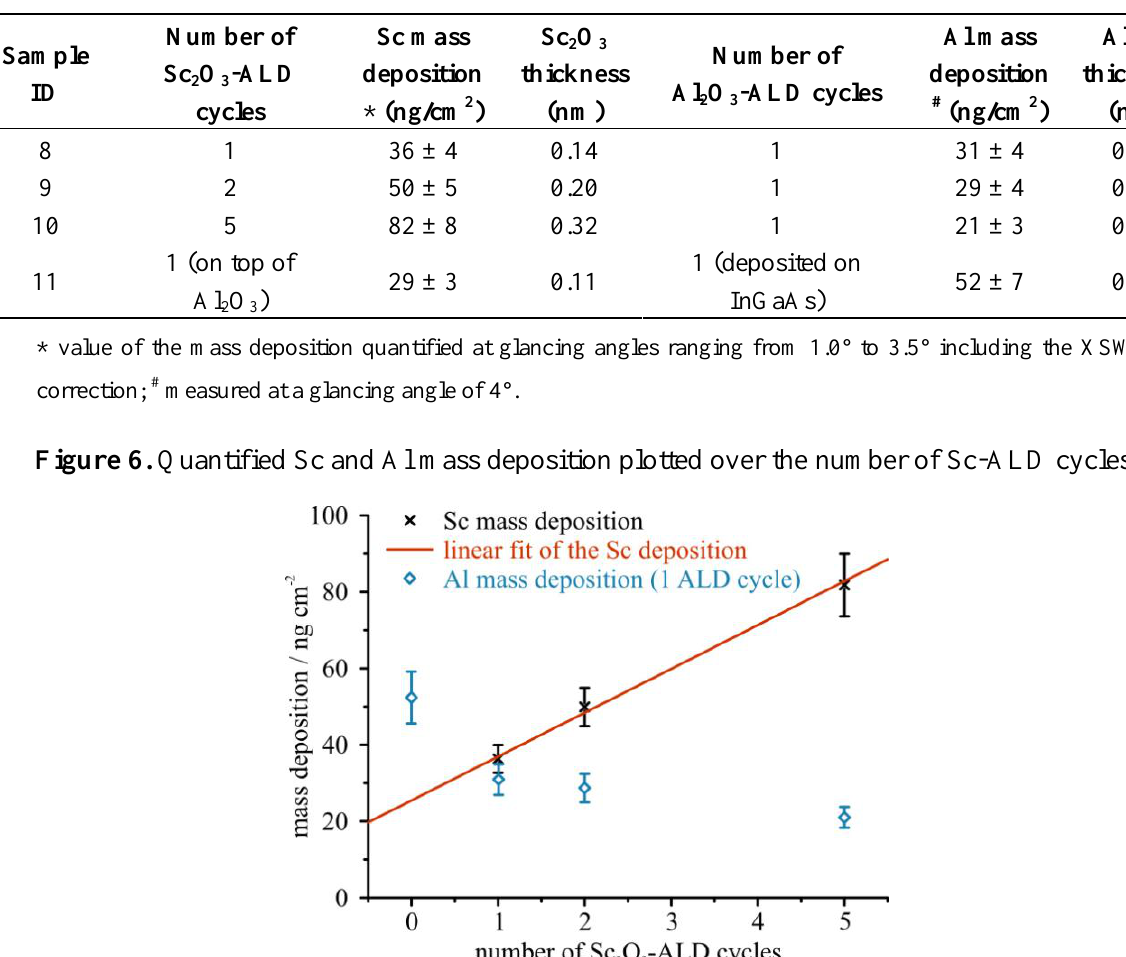
Table 3. Mass deposition and high-k layer thickness of sample set 2 determined by GIXRF. For better clarity, the respective mass deposition was transferred into a layer thickness assuming the bulk density and a 2 to 3 stoichiometry.